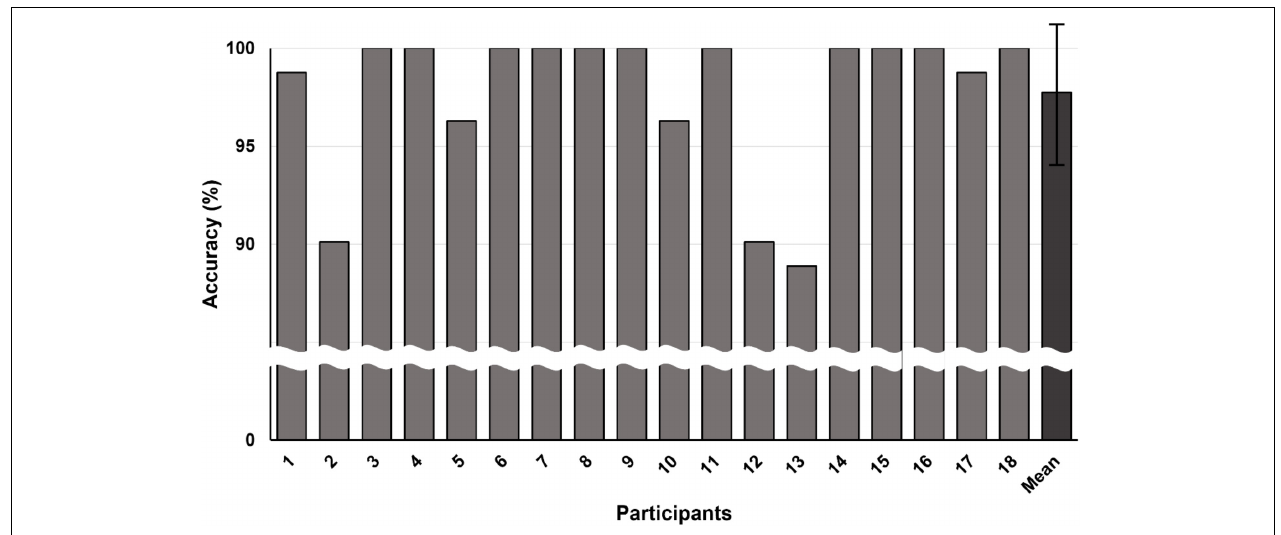
FIGURE 5 | Accuracy of classifying three directions (left, middle, and right) using hEOG for each participant. The grand averaged classification accuracy was 97.74 ± 3.89% (denoted by “Mean” in the